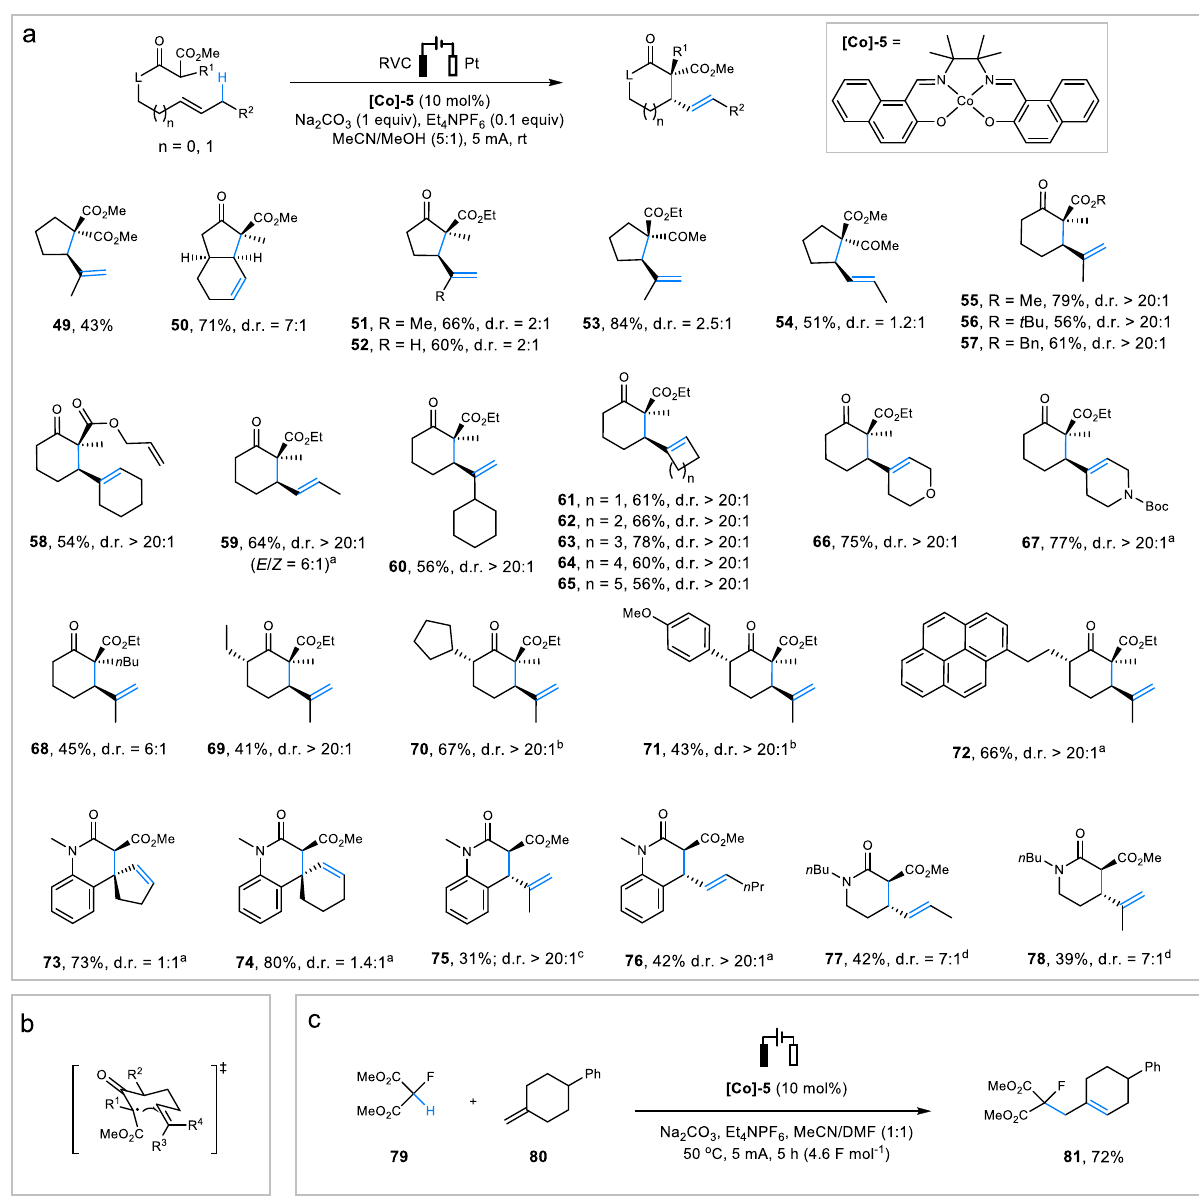
Fig. 3 Scope of allylic C – H alkylation. a Intramolecular allylic C – H alkylation. Reaction conditions: substrate (0.3 mmol), MeCN (5 mL), MeOH (1 mL),